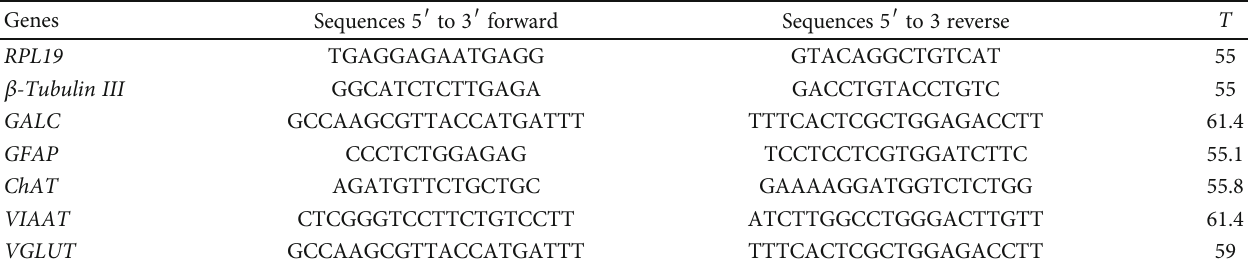
Table 2: Primers used for qRT-PCR analysis of cultures. T : annealing temperature in ° C of primers.